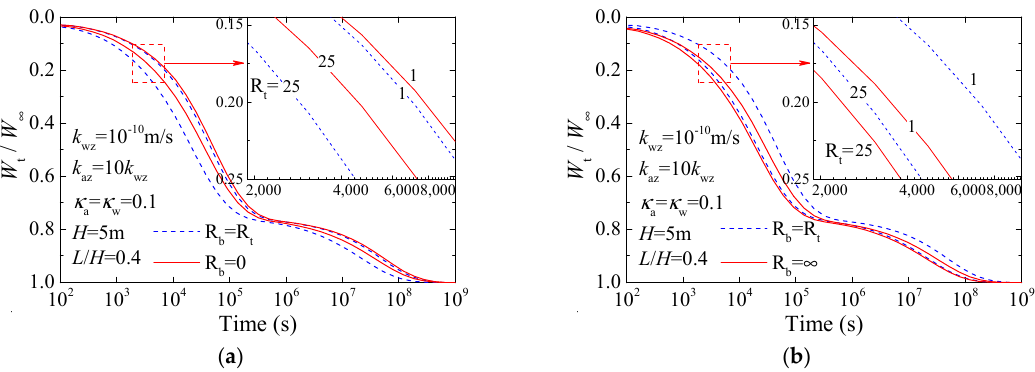
Figure 8. Variations of soil layer settlement under asymmetrical vertical impeded drainage boundary with different drainage efficiencies: ( a ) R b = 0 and ( b ) R b = ∞